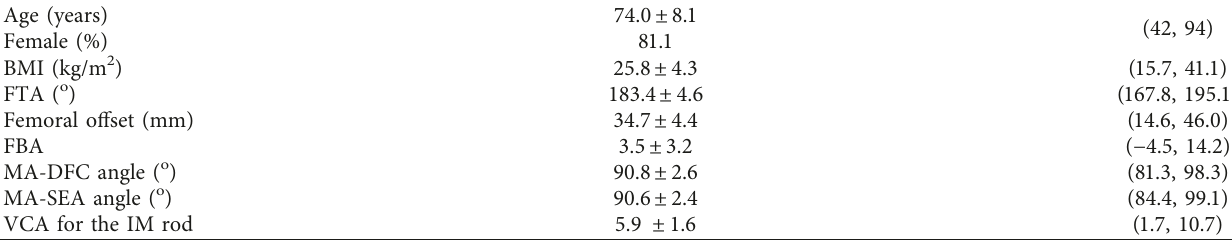
Table 1: Patient demographics, clinical characteristics, and angular parameters.